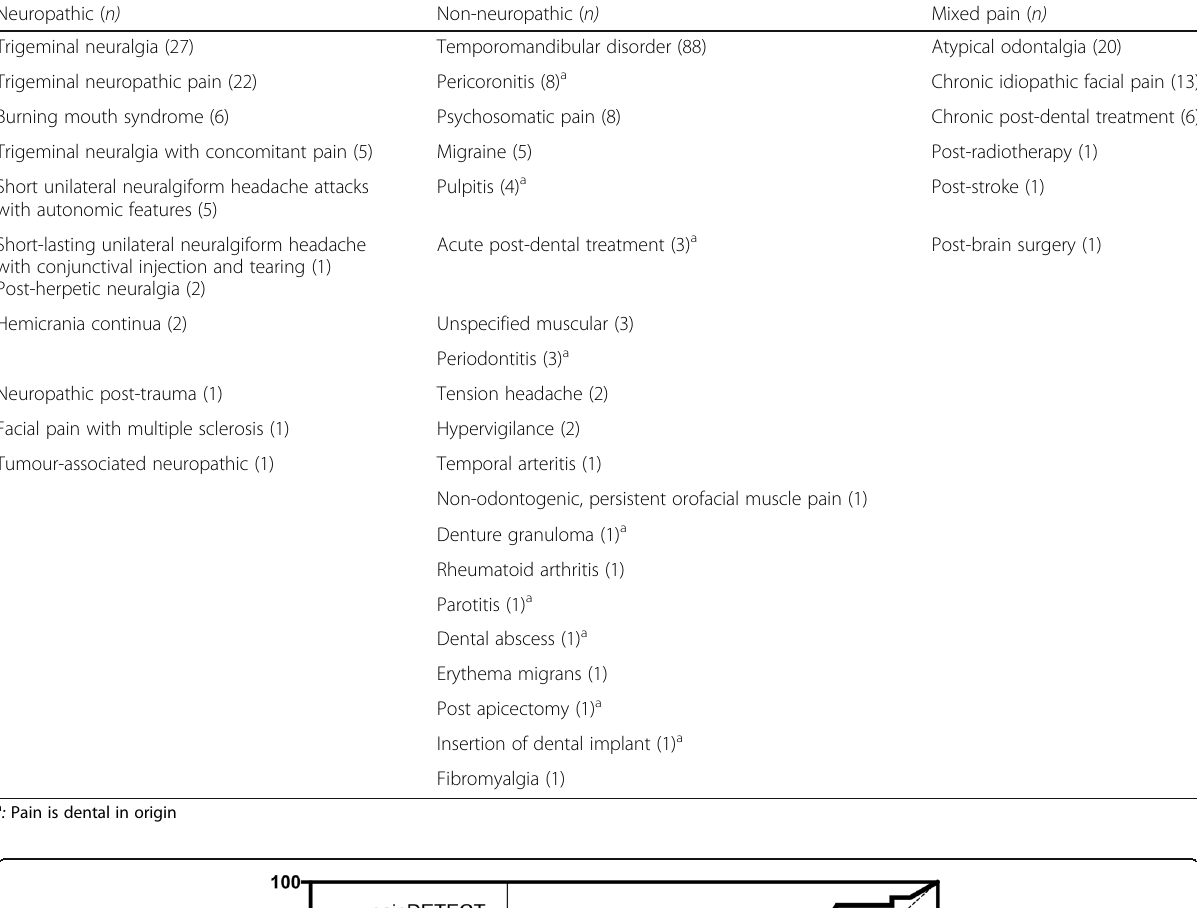
Table 2 Classification and frequency of OFP diagnoses